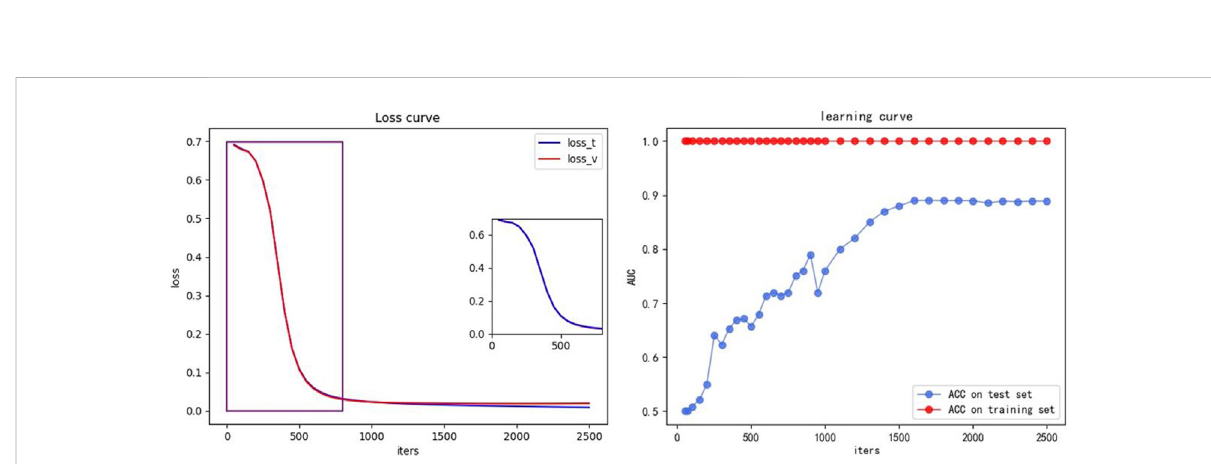
FIGURE 8 Lossandlearningcurve.Thesmallgraphontheleftshowsthelosscurve,thebluecurve(loss_t)indicatesthelossofthetrainingset,andthered curve (loss_v) indicates the loss of the test set. The small graph on the right shows the learning curve, the red curve (ACC on training set) indicating the ACC of the training set, and the blue curve (ACC on test set) indicates the ACC of the test